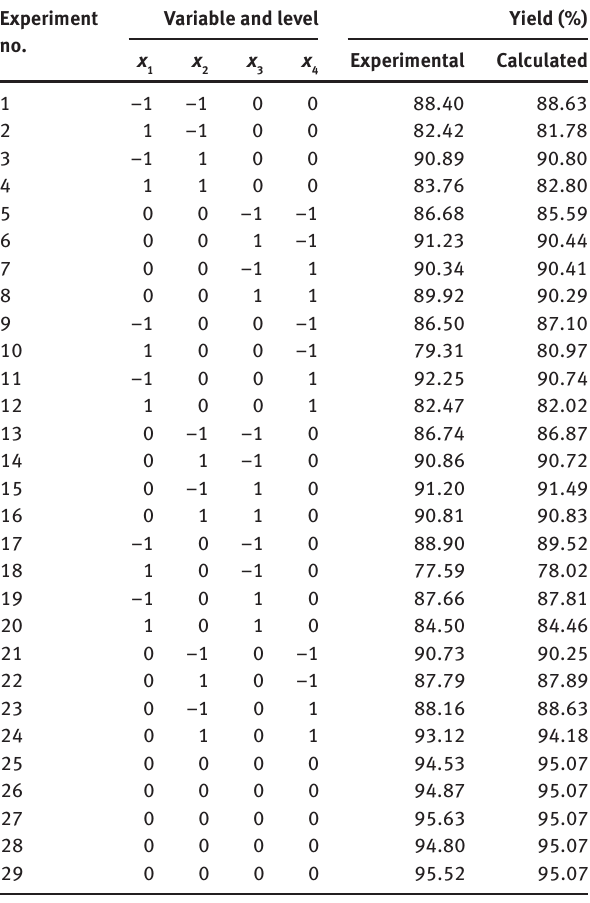
Table 3: List of experimental design and response values obtained for oxidation of BzOH over [DMBPSH]H